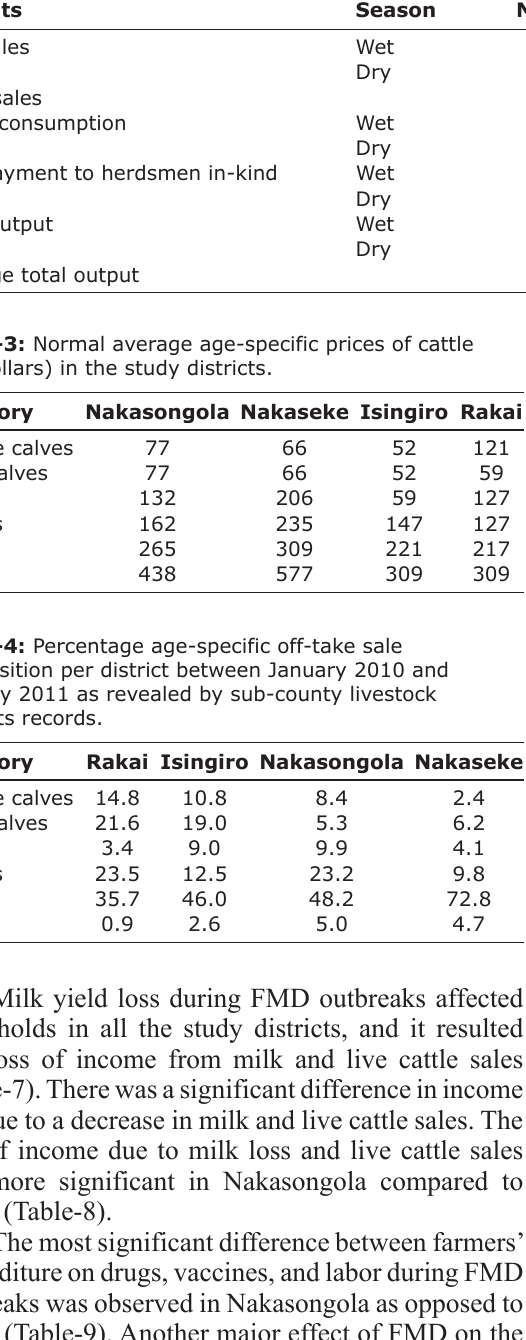
Table-2: Average annual total revenue from milk in US dollars per household in the study districts. Outputs